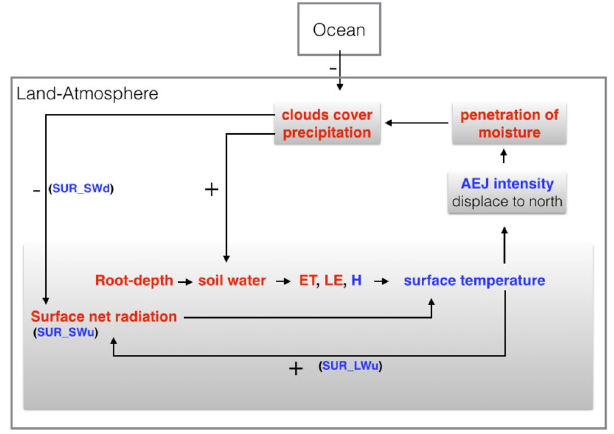
Figure 5. Schematic diagram for the sequence of processes underlying the increase in precipitation over the Sahel/N-Aust, as a consequence of land cover change from low-level vegetation to large-scale afforestation system. The starting point is the increased root depth associated with afforestation, and the associated increased in soil water mining. Red and blue colors indicate increase or decrease values,